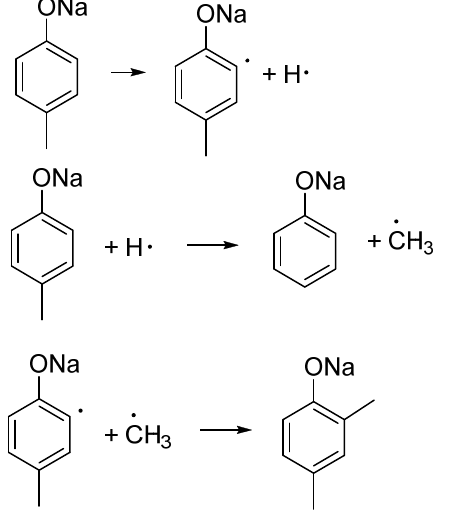
Figure 10. Q-TOF spectrum of sodium p -cresolate collected at 495 °C.